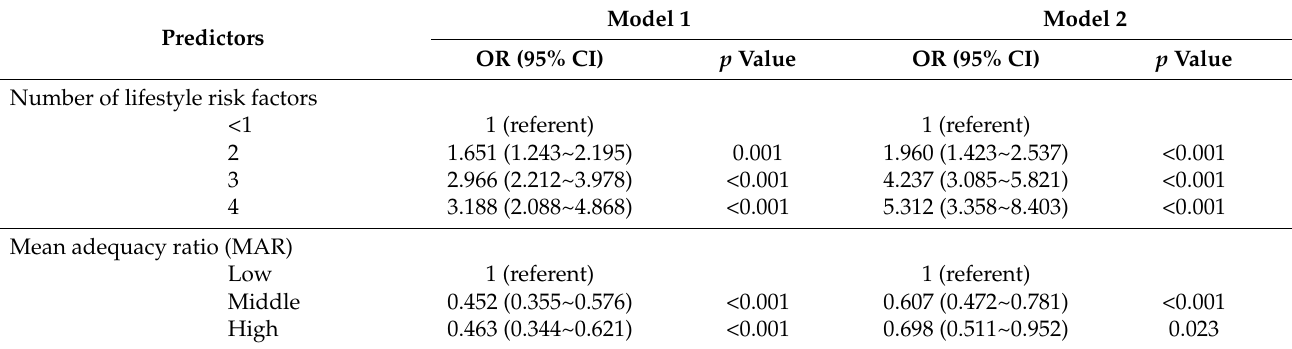
Table 3. Odds ratios (ORs) and 95% confidence intervals (CIs) of depression by lifestyle risk factors and nutritional adequacy